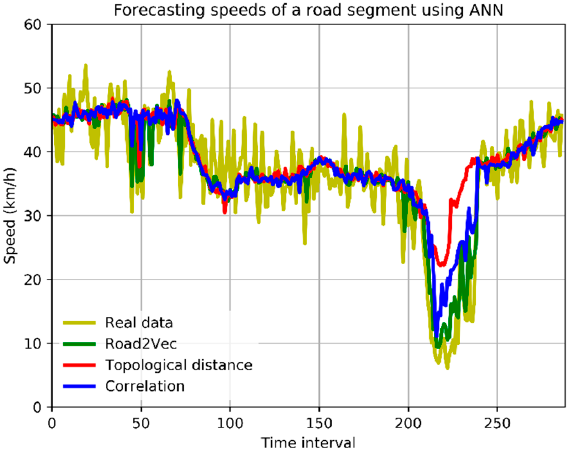
Figure 6. Forecasting vehicular speeds of a road segment using ANN with different spatio-temporal inputs.